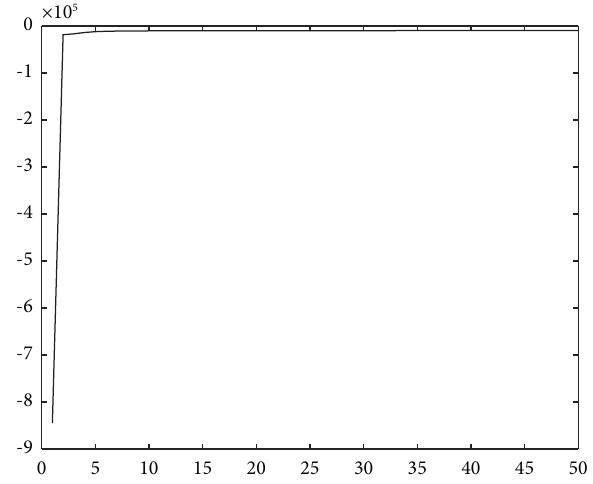
Figure 9: HMM training curve of TE process.